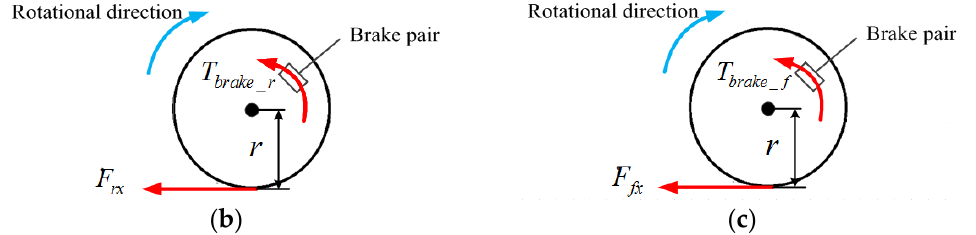
Figure 2. Scheme of the 5-DOF vehicle model: ( a ) denotes the whole vehicle. ( b , c ) denote the rear and front wheels, respectively.